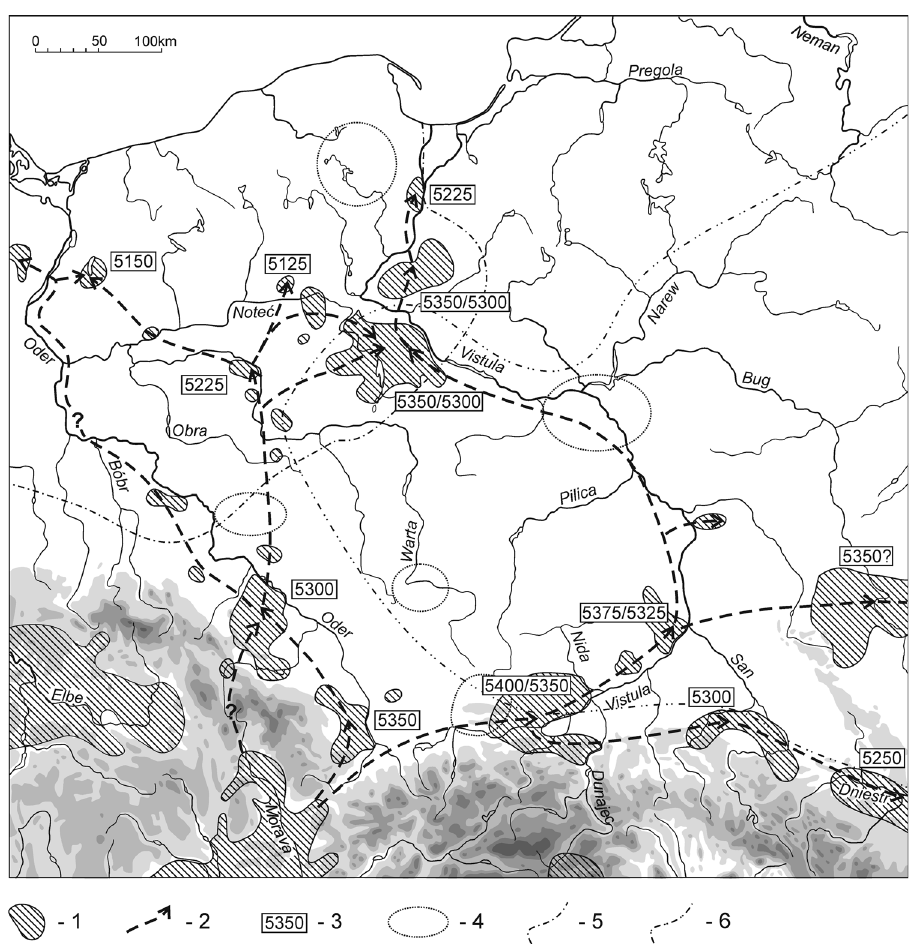
Figure 2: The spread of the LBK in the north - eastern part of Central Europe ( based on Koz ł owski & Nowak, 2019, Figure 4; Nowak, 2019, Figure 3, with modi fi cations ) . ( 1 ) Enclaves settled by LBK communities ( in the period of the greatest territorial extent, i.e. in the classical and late phases ) ; ( 2 ) basic routes of migrations of the LBK groups ( in the period of stabilisation they became axes of contacts between settlement enclaves ) ; ( 3 ) averaged datings of the appearance of the LBK in a given area; ( 4 – 6 ) the main, Late Mesolithic units; ( 4 ) Late Komornica; ( 5 ) post - Maglemose; and ( 6 ) Janis ł